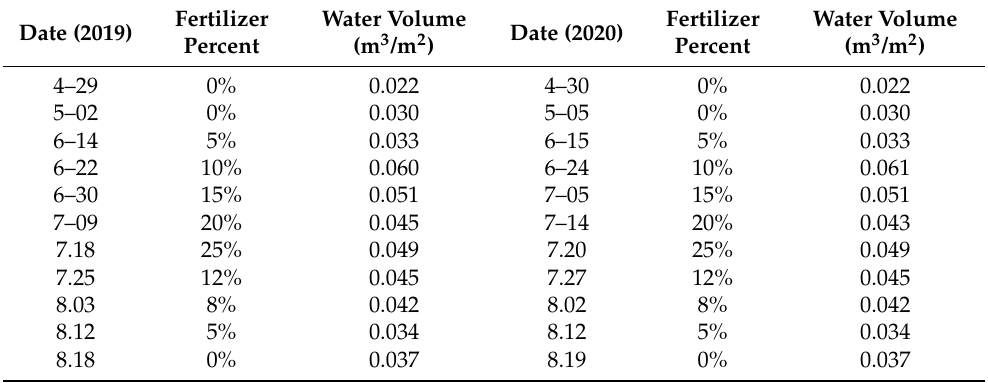
Table 1. Application amount of integrated drip irrigation of water and fertilizer in field experiment.